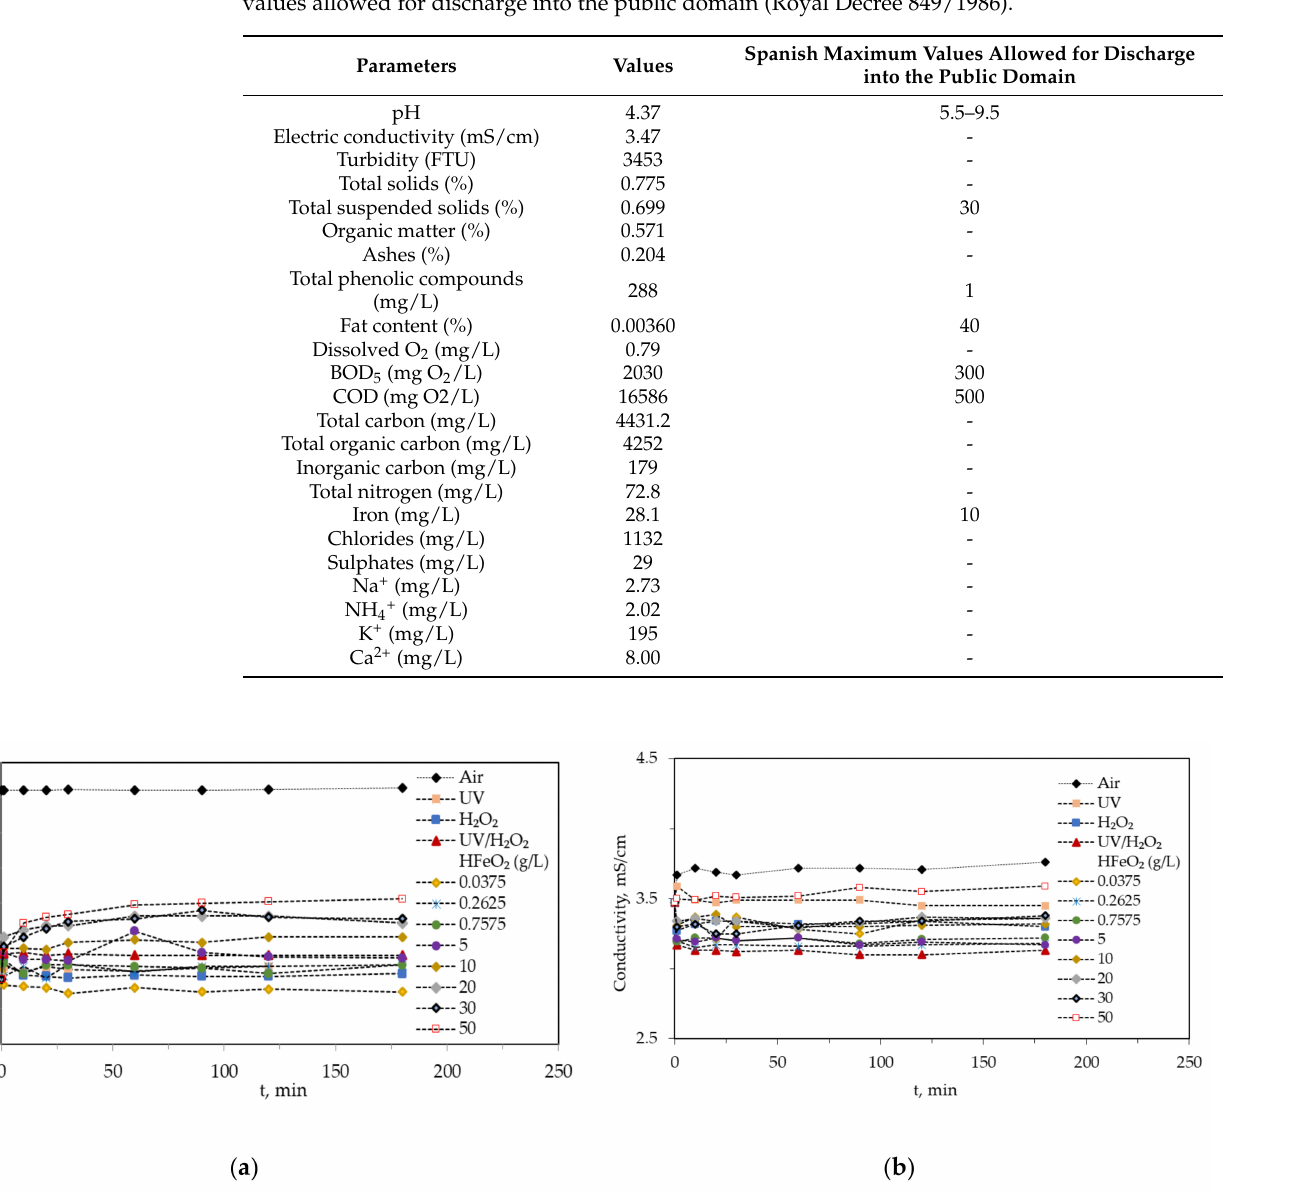
Figure 1. pH ( a ) and conductivity ( b ) variation throughout of the experiments for different chemical oxidation sys- tems: air, UV, H 2 O 2 , UV/H 2 O 2 , and UV/catalyst/H 2 O 2 , with different catalysts doses. Common operating conditions: COD initial = 16586 mg O 2 /L, H 2 O 2 = 35.3 g/L, T = 20 ◦ C, agitation speed = 700 rpm, and pH =